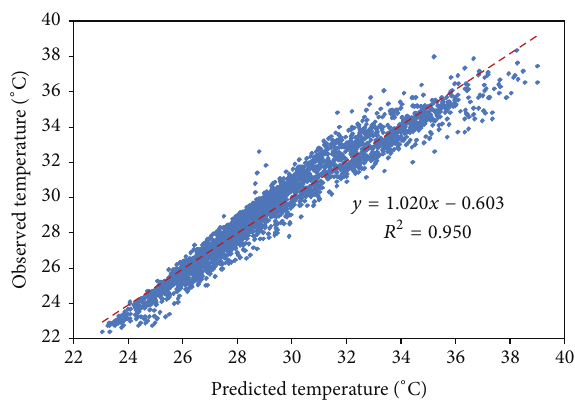
Figure 6: Comparison between measured and morphed hourly temperature at site A.